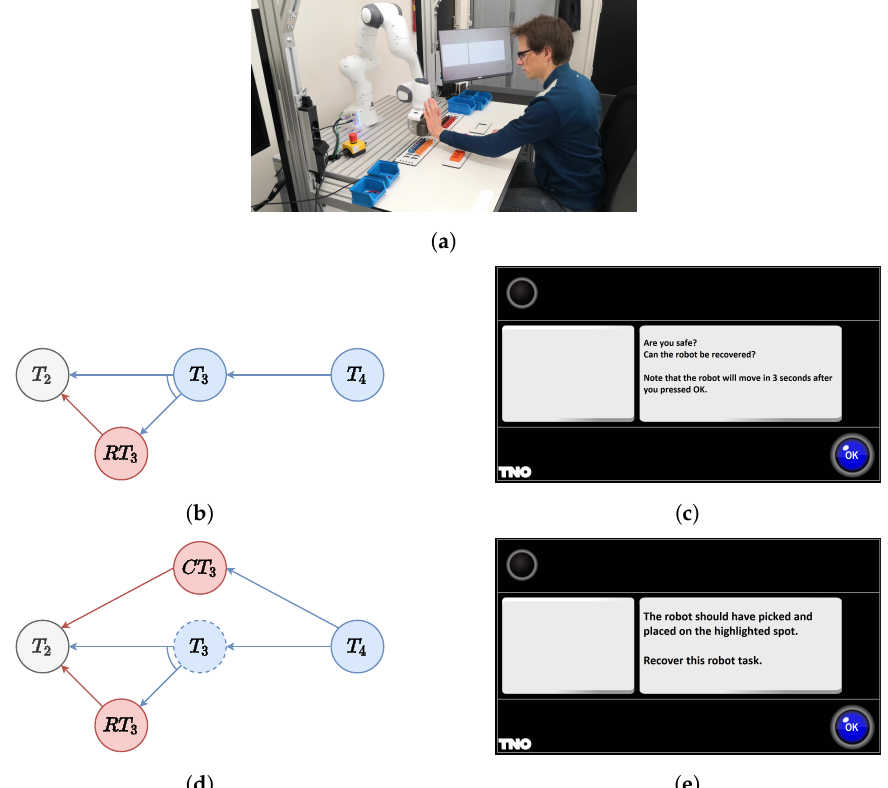
Figure 6. Failure of of T 3 . ( a ) The human hindering the robot. ( b , d ) The AND/OR graph locally adapted. In ( c ), the Arkite system asks if the human is safe before moving again, while in ( e ), the instruction to guide the human operator in correcting the task is